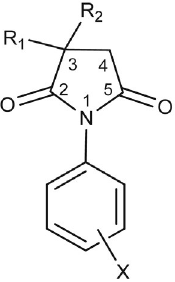
Figure 1. The structure of the investigated succinimides: ( 1 ) R 1 =H, R 2 =Ph, X=H; ( 2 ) R 1 =Ph, R 2 =Ph, X=H; ( 3 ) R 1 =H, R 2 =Ph, X=4-Cl; ( 4 ) R 1 =Ph, R 2 =Ph, X=4-Cl; ( 5 ) R 1 =H, R 2 =Ph, X=3-Cl; ( 6 ) R 1 =Ph, R 2 =Ph,